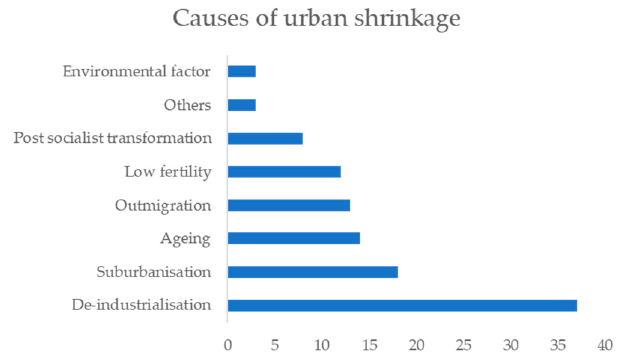
Figure 3. Causes of urban shrinkage. (Authors’ elaboration based on Joint Research Centre data [58].).